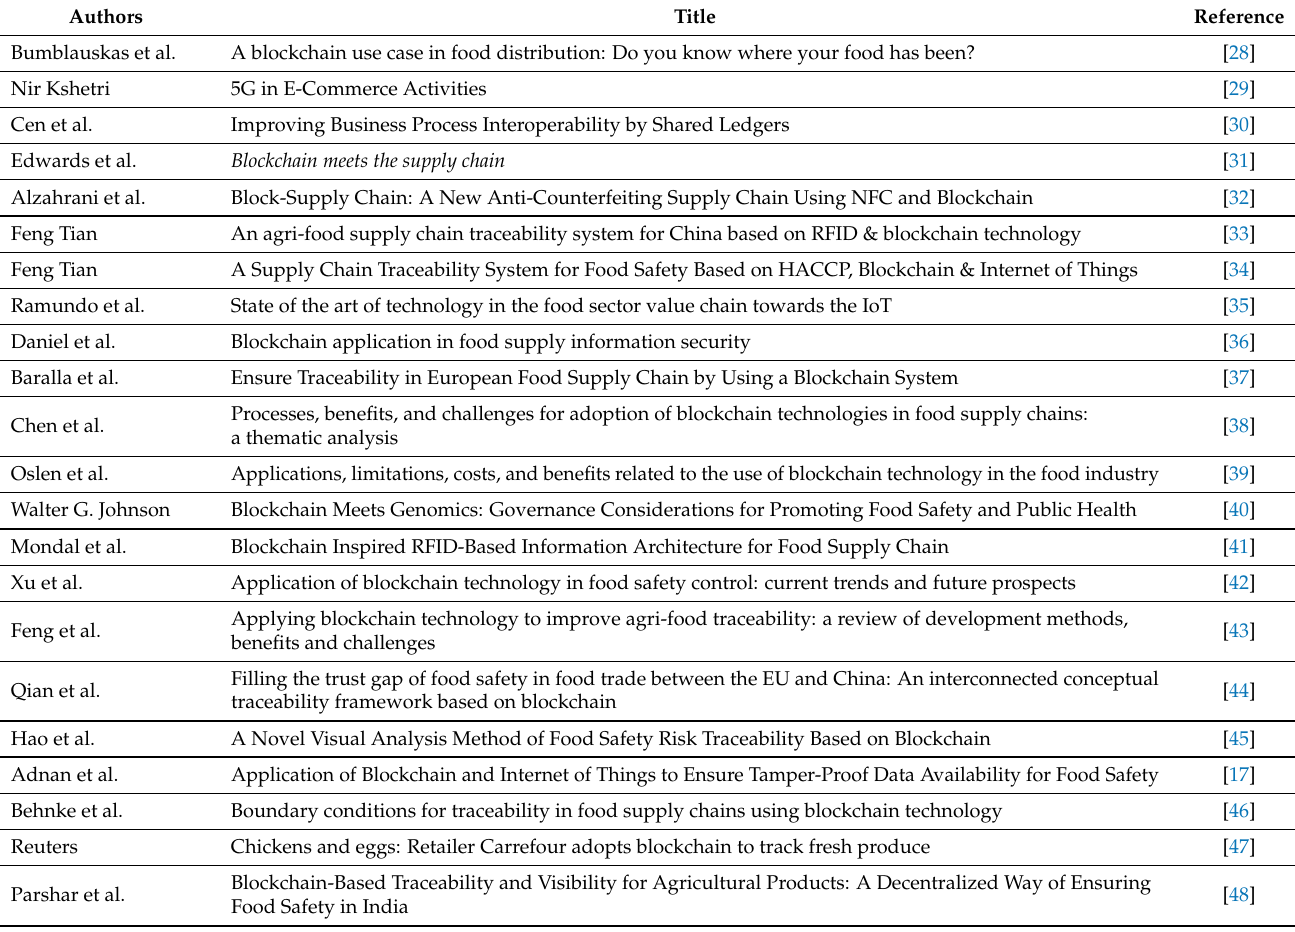
Table 1. Application of Blockchain in the Food Supply